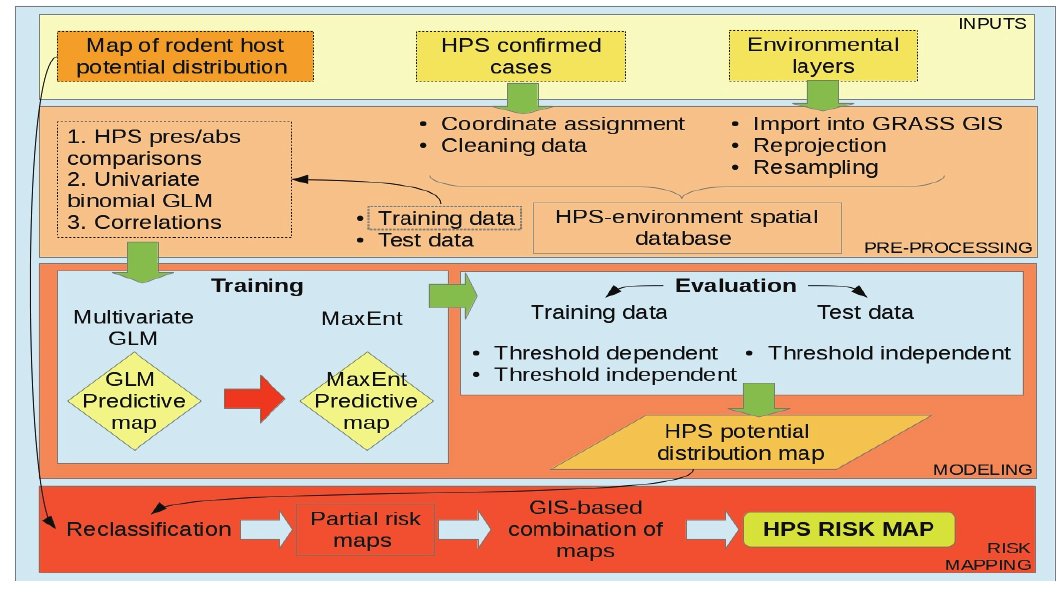
Figure 5. Schematic representation of the methodological